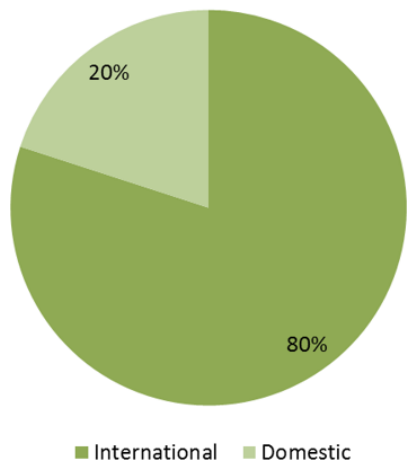
Fig. 8. The main destinations of flights from Warsaw Chopin Airport (25–31.03.2019) – division into domestic and foreign